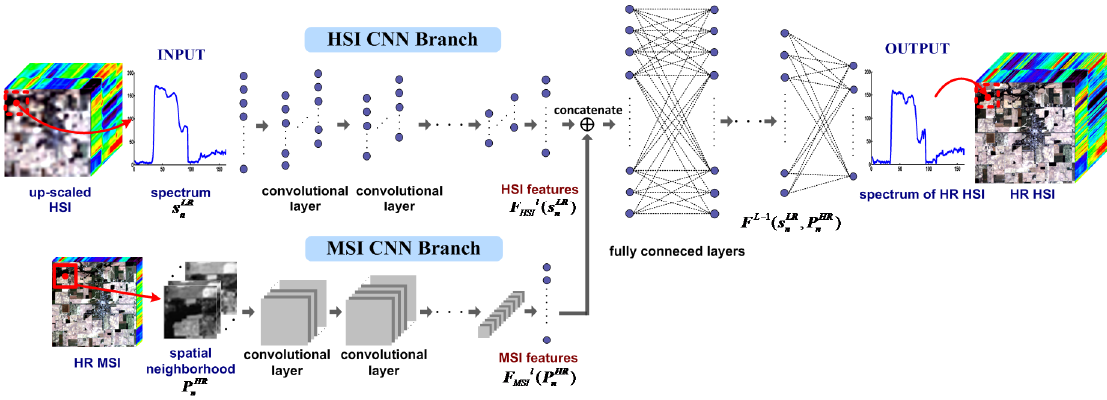
Figure 4. The proposed two branches CNN architecture for HSI-MSI fusion.